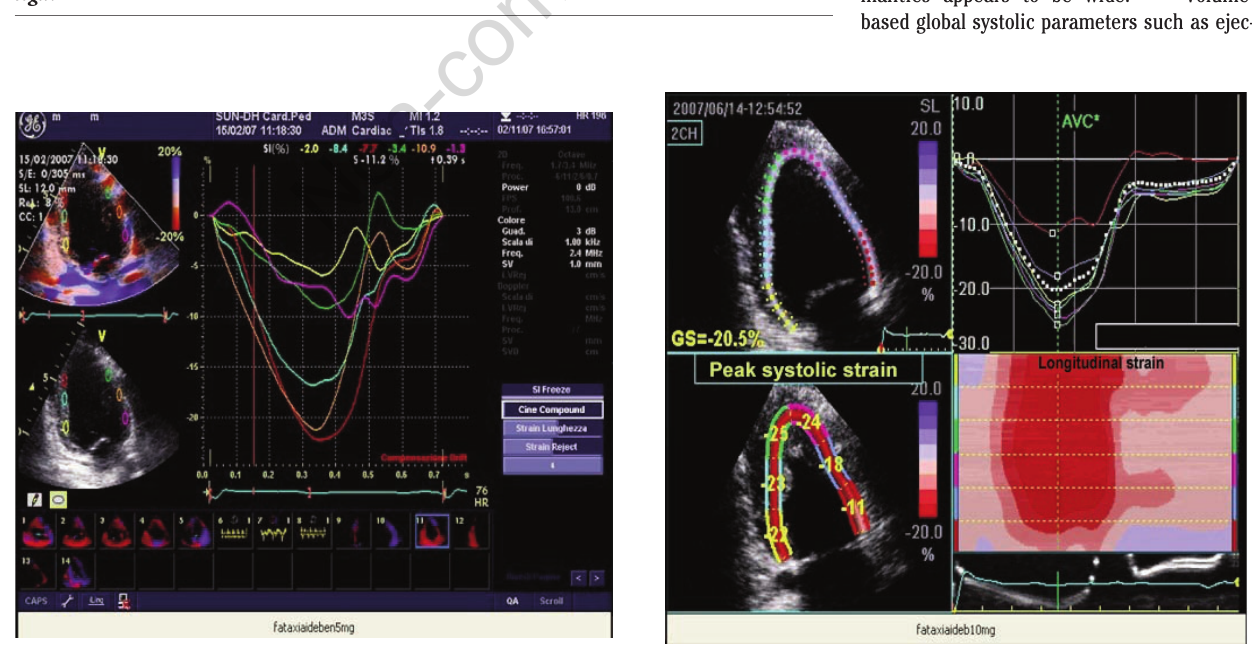
Figure 2. A and B) A case of Friedreich ataxia: of interest strain rate imaging is able to detect linear improvements in longitudinal myocardial deformation when higher dosage of idebenone were